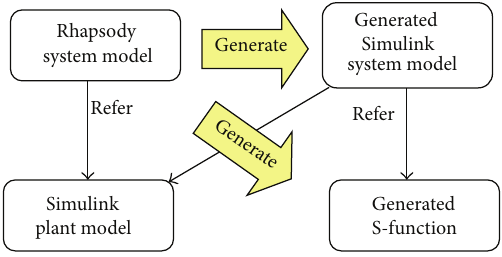
Figure 3: New integration.